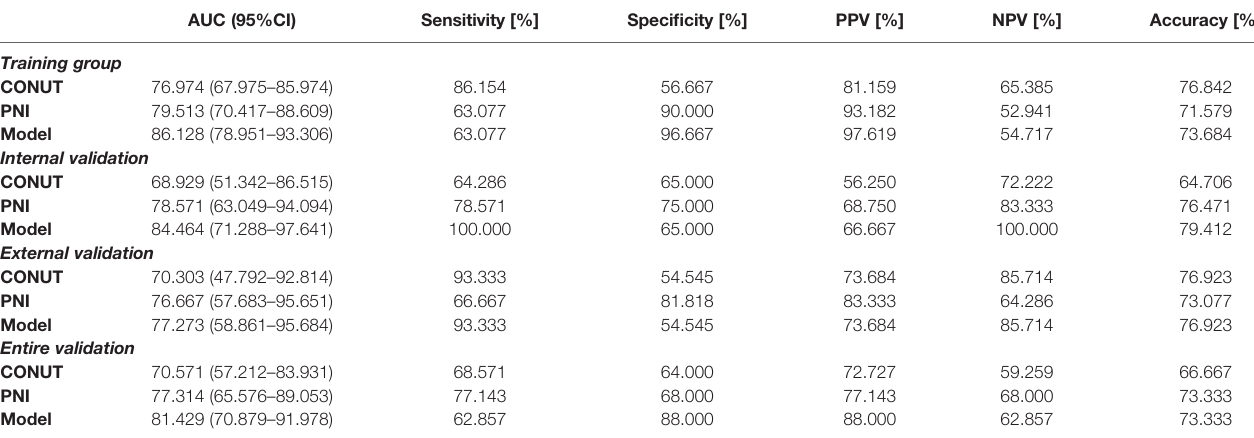
TABLE 3 | Diagnostic performance of different models for predicting the prognosis of pancreatic ductal